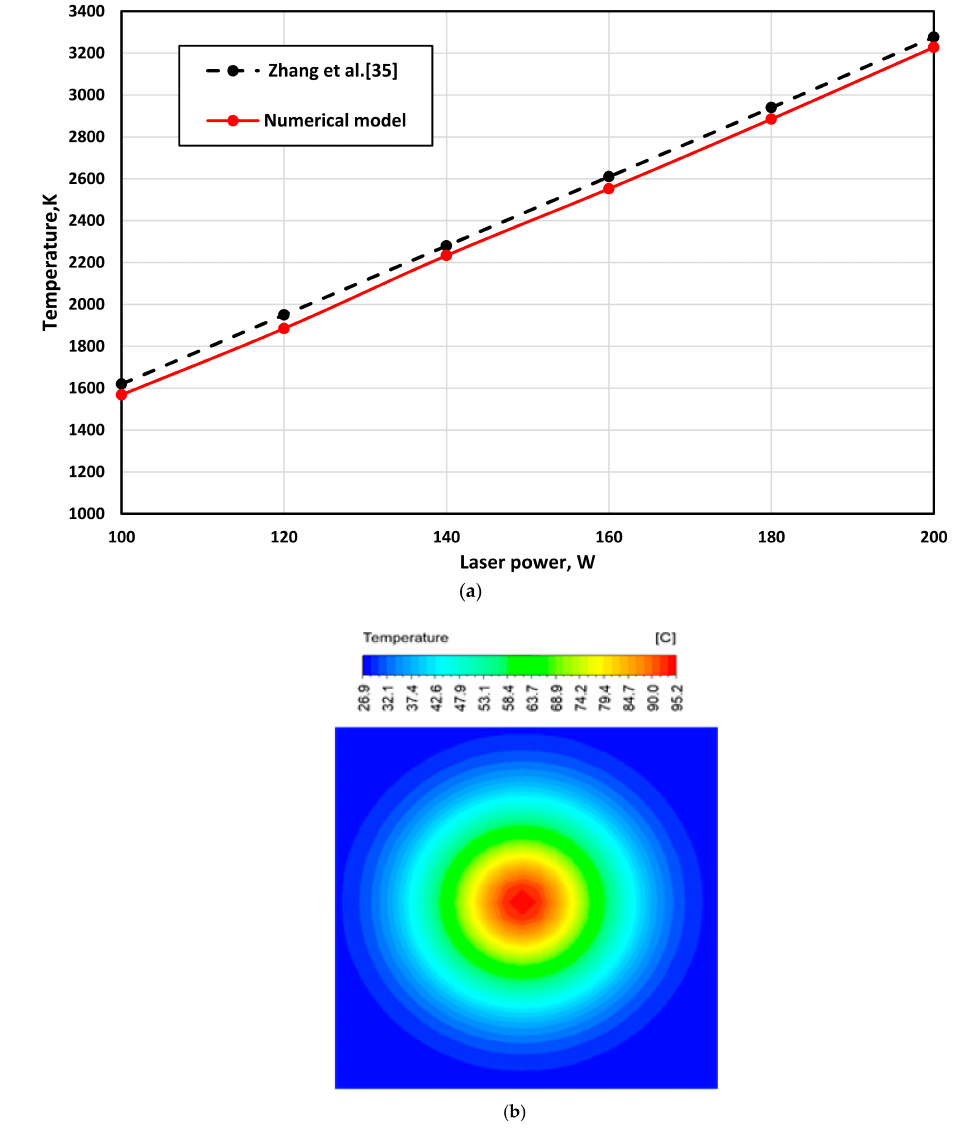
Figure 8. ( a ) Numerical model validation with Zhang et al. [35], ( b ) Temperature contour [34] obtained using the same conditions used in